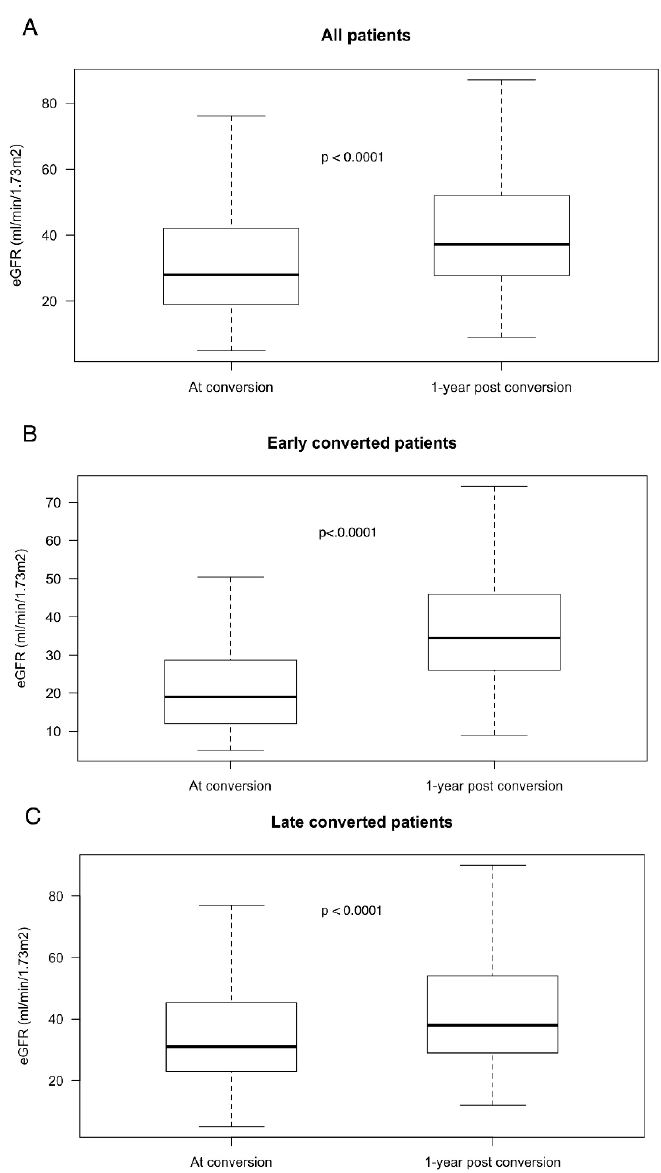
Figure 4. Improvement in renal function at 1-year post-belatacept conversion. Boxplots of eGFR at conversion and at 1-year after conversion to belatacept in all patients ( A ) N = 453, in patients converted before 6 months ( B ) N = 121 and in patients converted after 6 months ( C ) N = 332.